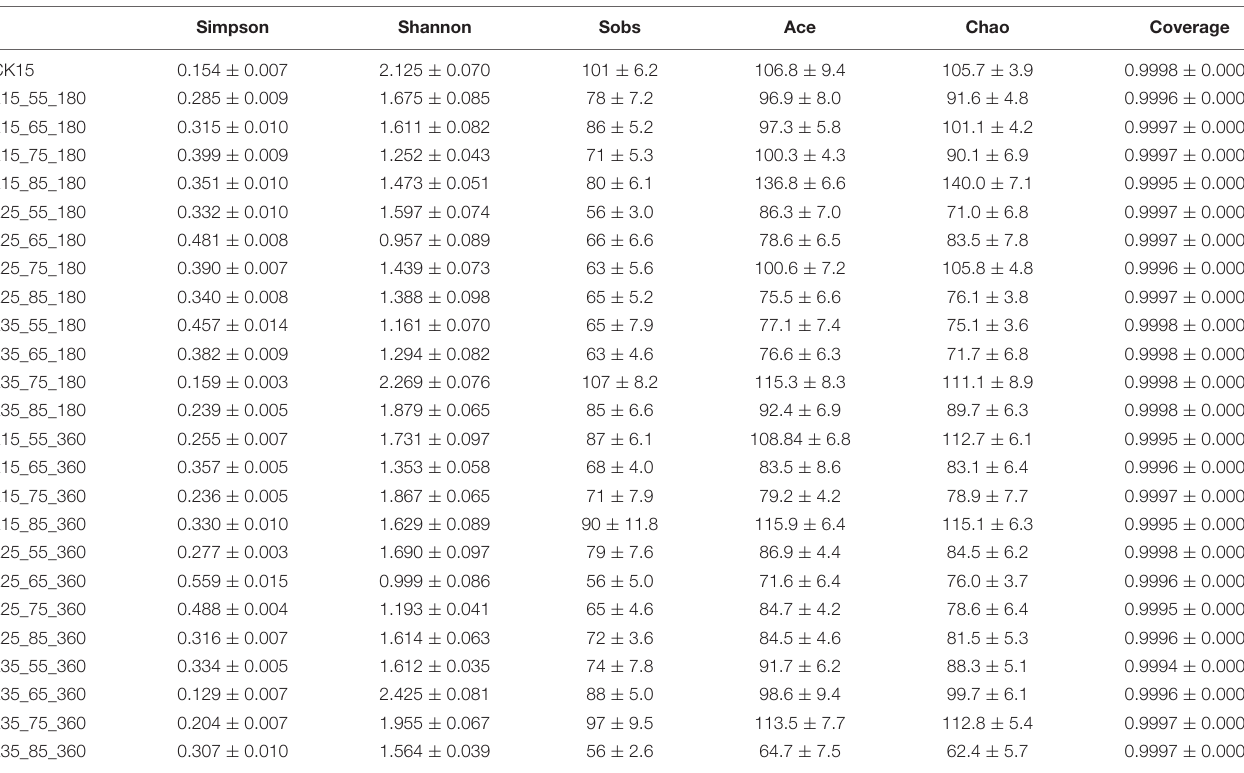
TABLE 1 | Statistical table of barley fungal community diversity indices in initial barley and after storage. Simpson Shannon Sobs Ace